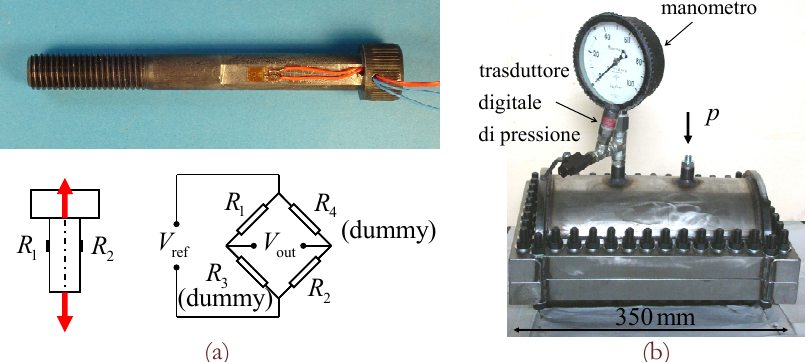
Figura 9: (a) Vite estensimetrata, l’utilizzo di due estensimetri permette di eliminare eventuale flessione ed effetto di temperatura, oltre ad ottenere sensibilità del segnale doppia. (b) Attrezzatura sperimentale per riprodurre in scala ridotta una cassa flangiata con bullonatura di tenuta.